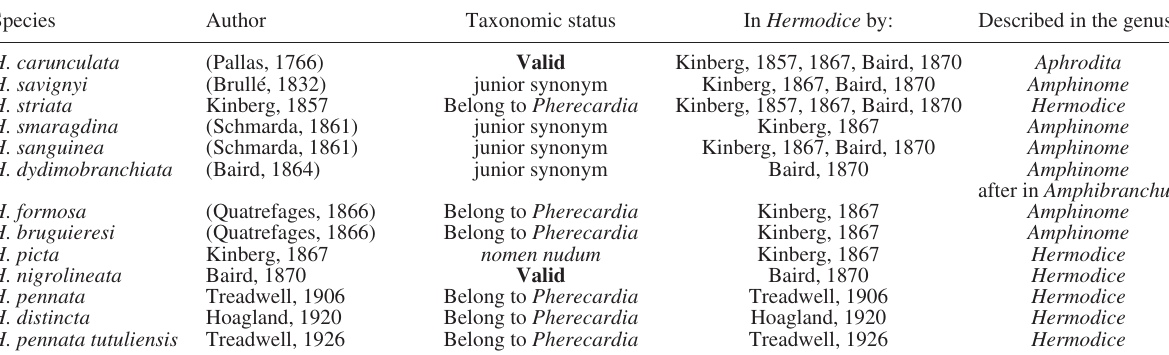
Table 1. – Taxonomic status of species considered in Hermodice